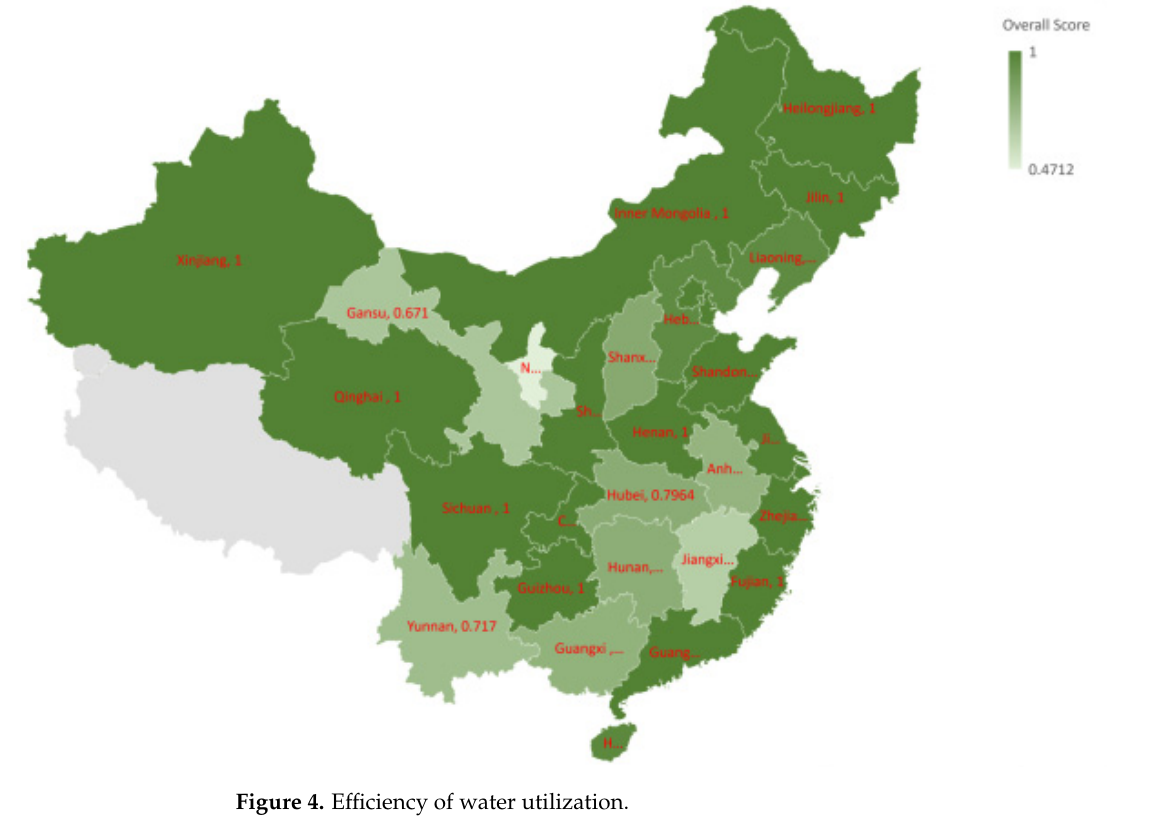
Figure 4. E ffi ciency of water utilization. Figure 4. Efficiency of water utilization.